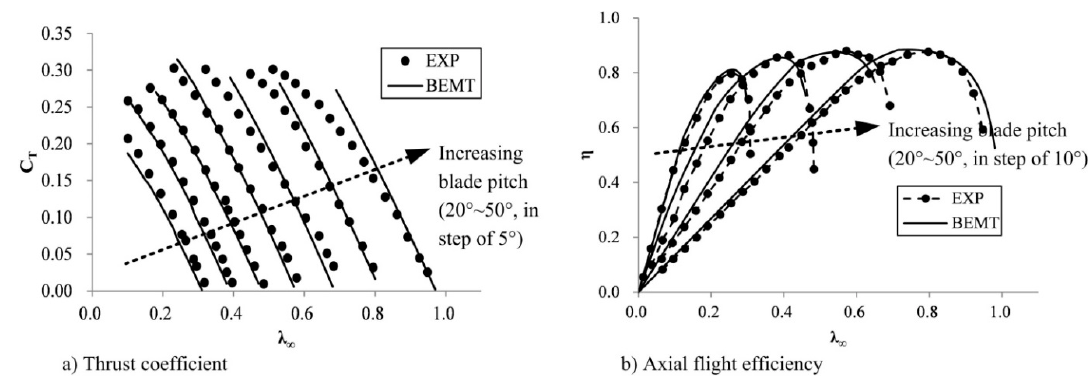
Figure 5. Comparison of the BEMT-predicted result and experimental data for axial flight at various inflow ratios.